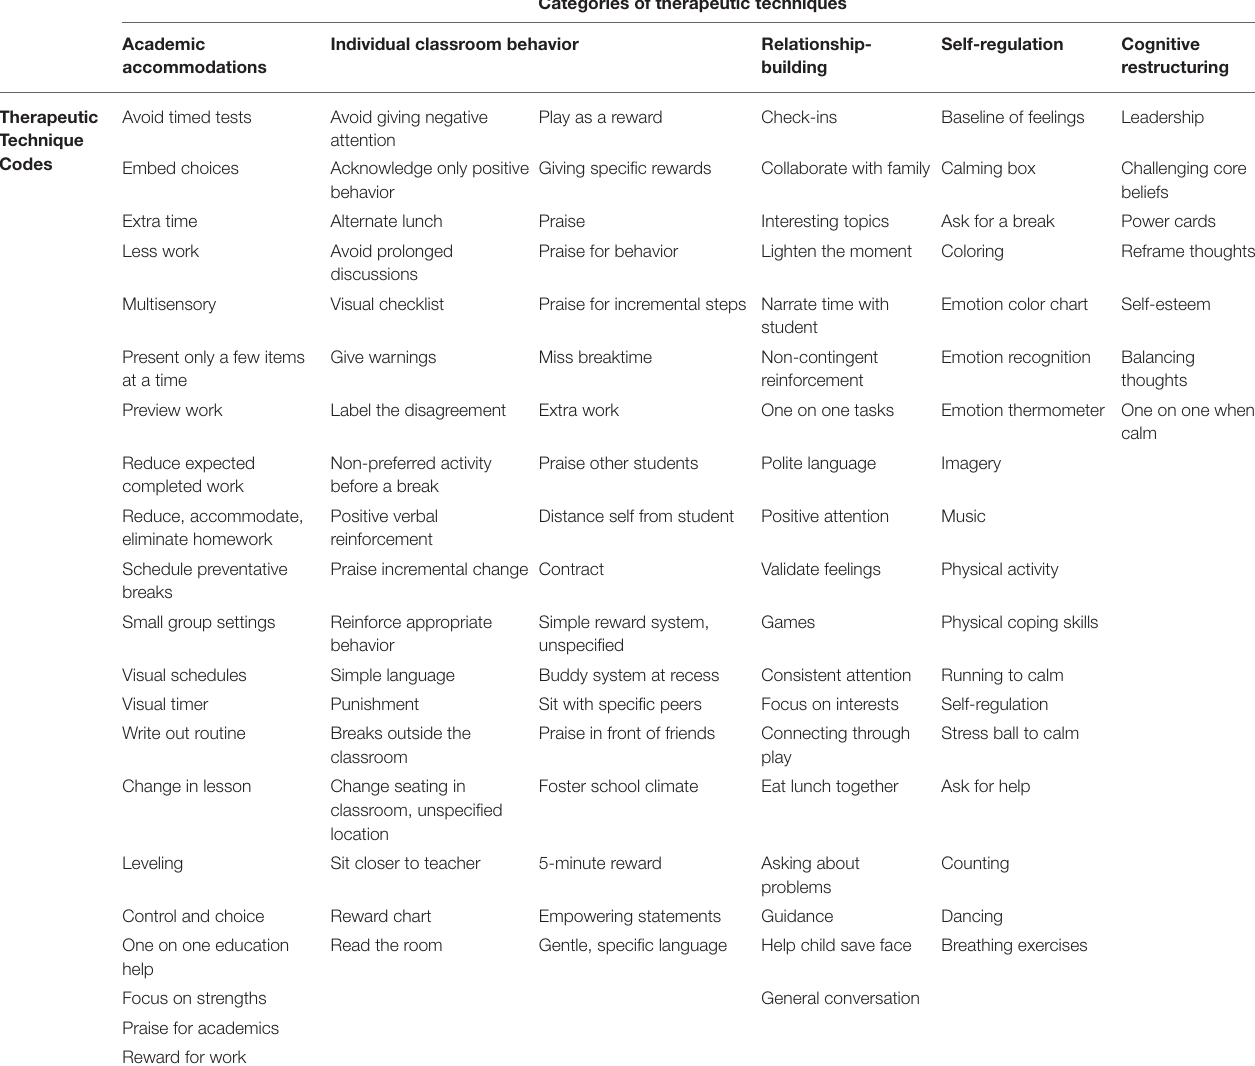
TABLE 3 | Therapeutic techniques categories and